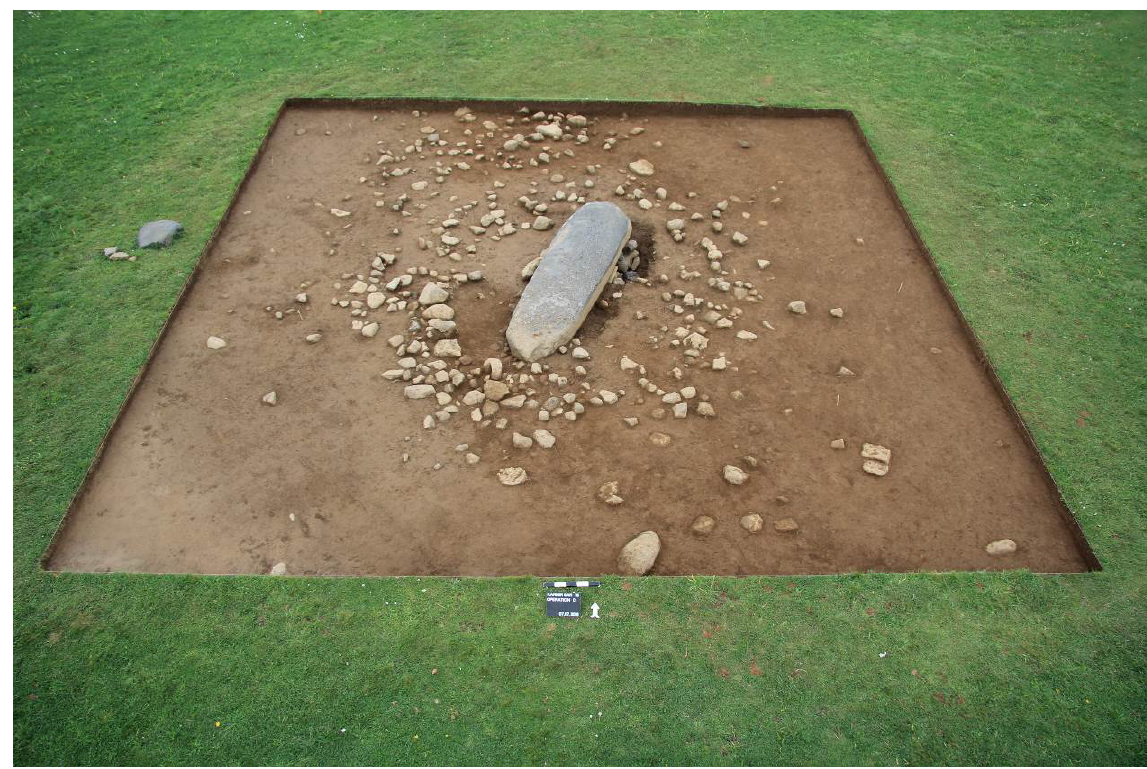
Figure 4. Fallen vishap covering its former construction pit in KS D, facing North (photo by P.